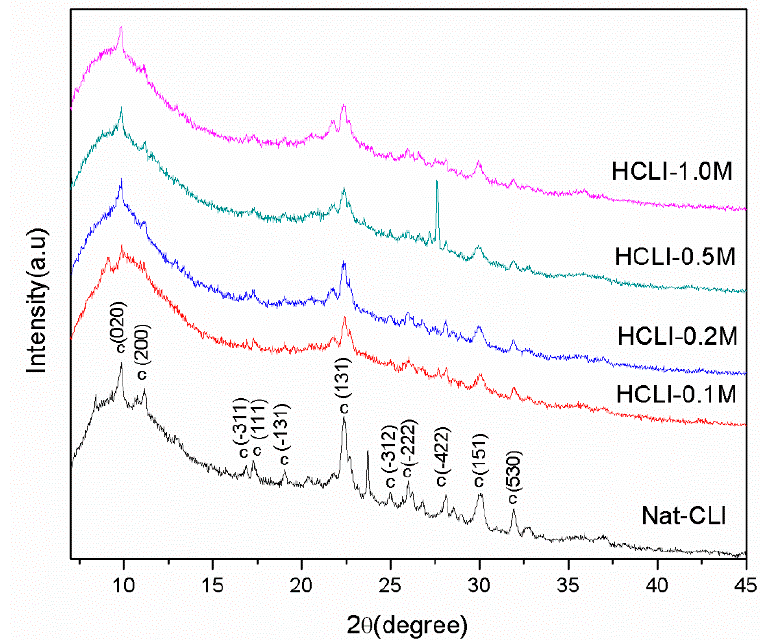
Figure 1. X-ray diffraction ( XRD) patterns of non- and acid-modified clinoptilolite-rich tuffs. Figure 1. X-ray di ff raction (XRD) patterns of non- and acid-modified clinoptilolite-rich tu ff